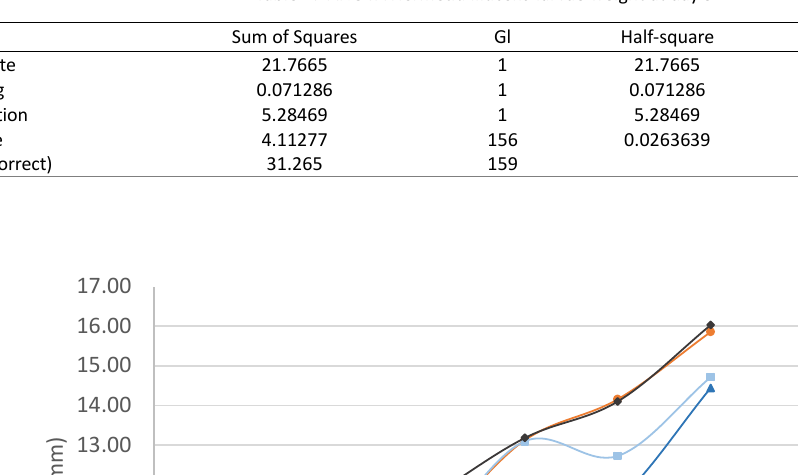
Table 2: ANOVA Hermetia illucens larvae weight at day 5